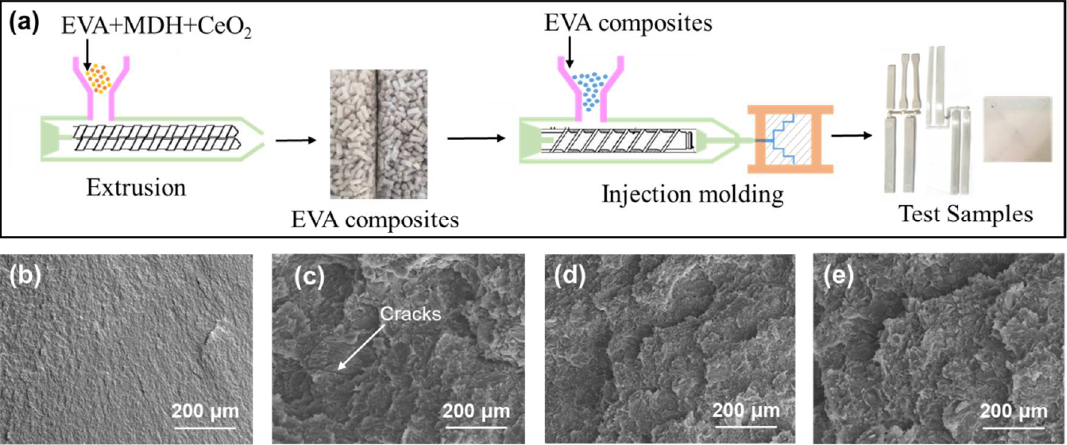
Figure 2. ( a ) Scheme of the samples preparation sequence, and SEM images of the composites cross-section: ( b ) EVA, ( c ) EM, ( d ) EMC3 and ( e ) EMC5.